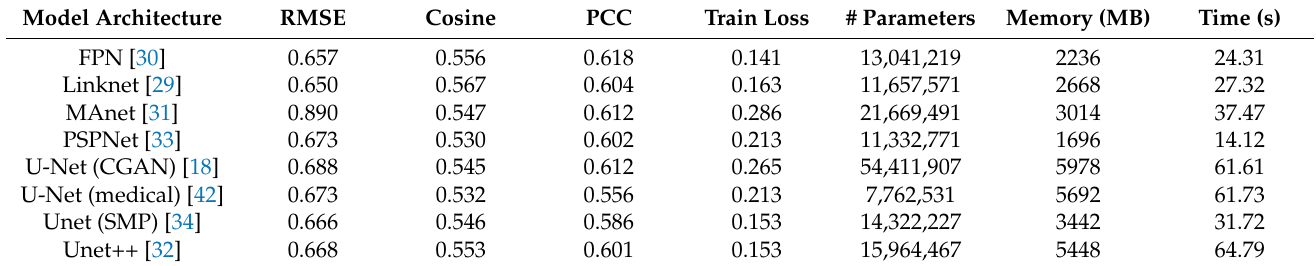
Table 2. Comparison of performance metrics across different model architectures. Root mean squared error (RMSE), cosine similarity (Cosine), and the Pearson correlation coefficient (PCC) are presented. Memory reflects the maximum memory consumption during training and time reflects the average training time per